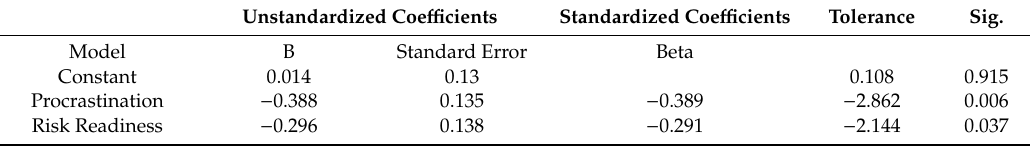
Table 5. Regression model parameters for the median quotas shift